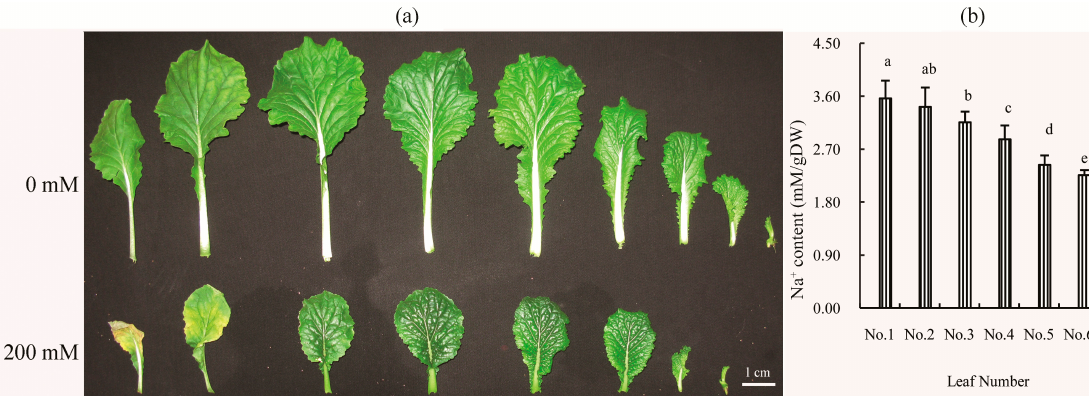
Figure 6. Effects of 200 mM NaCl stress on: the senescence ( a ); and the Na + content ( b ), in different leaf positions of plants exposed to 200 mM NaCl. The Na + concentrations were measured on Day 30 after salt treatment. The values are the means ( ± SD) of five replicates. Means followed by different letters indicate significant differences ( p < 0.05). The order of old leaves to young leaves is from left to right. Leaf number from No. 1 to No. 6 is from oldest leaf to younger leaf. The No. 1 leaf is the oldest leaf.